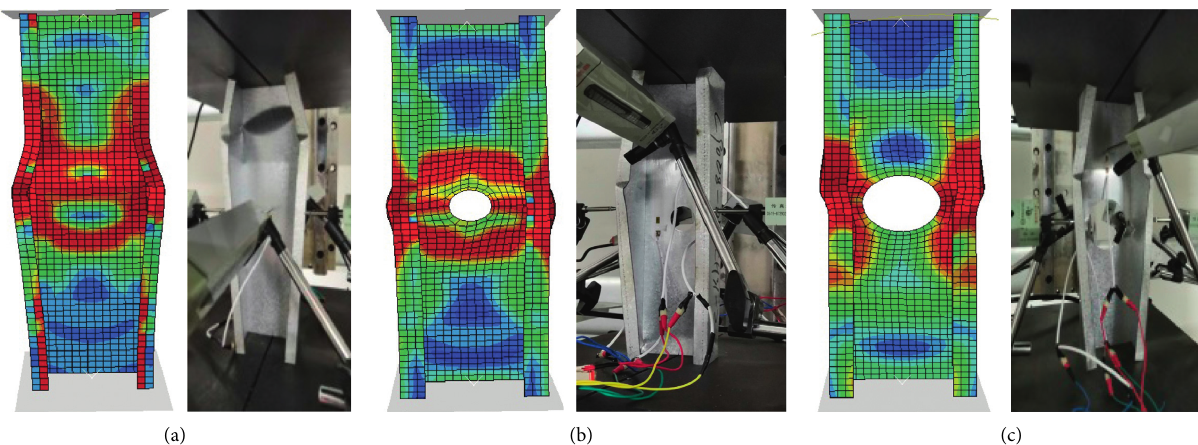
Figure 16: Comparison of buckling modes between test and FEA for section C9008 series. (a) d / h � 0. (b) d / h � 0.3. (c) d / h � 0.7.